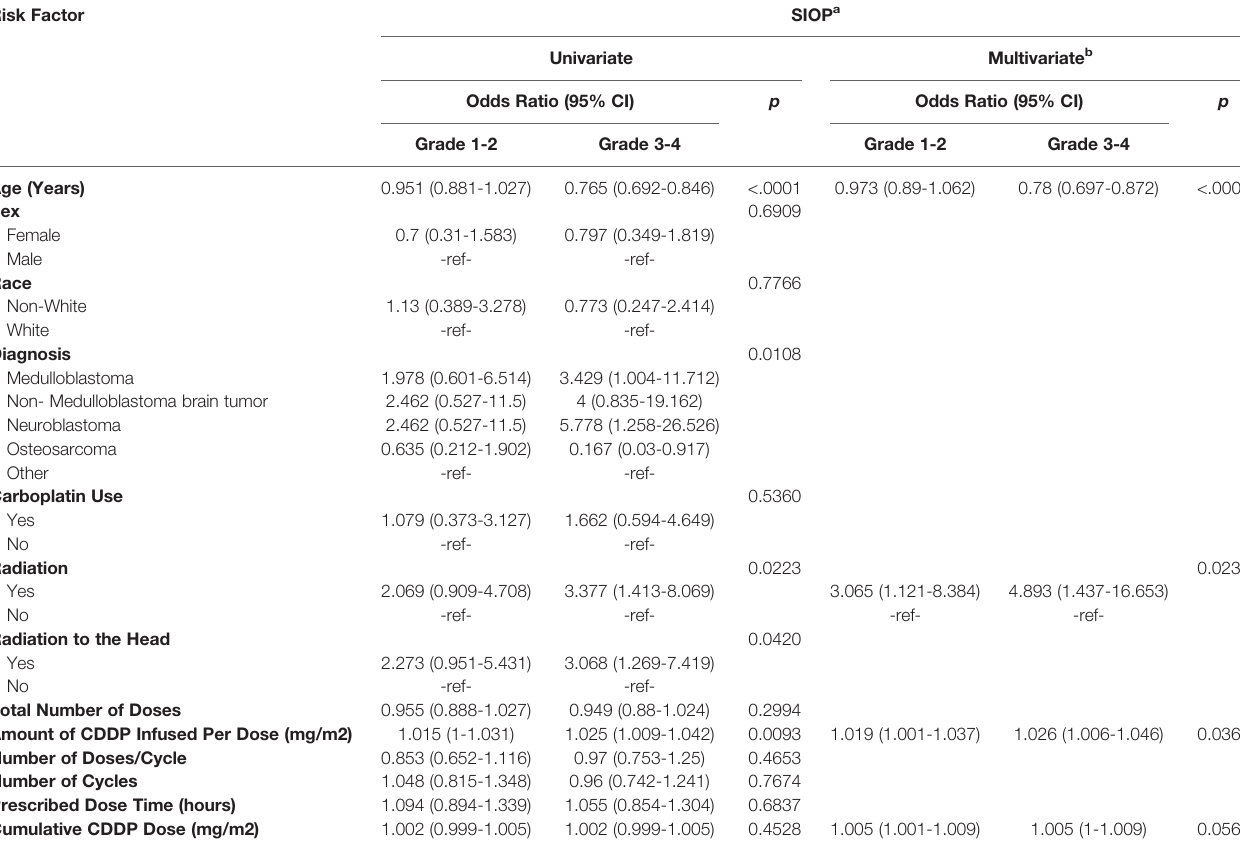
TABLE 3 | Univariate and multivariate multinomial logistic regression assessing risk factors for SIOP grade. Risk